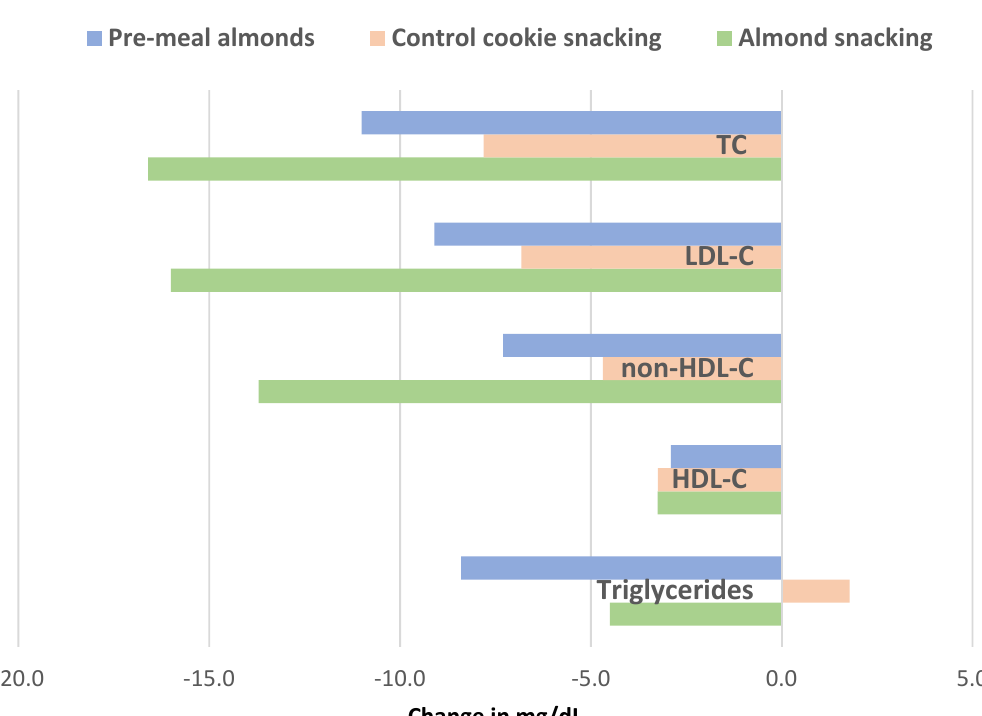
Figure 21. ( A , B ) Change in blood lipids from pre-meal almonds, almond snacks, and cookie snack control from baseline to 8 and 16 weeks [42].